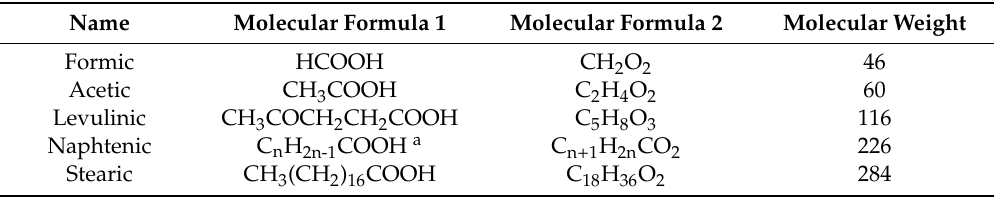
Table 4. The five acids detected in the